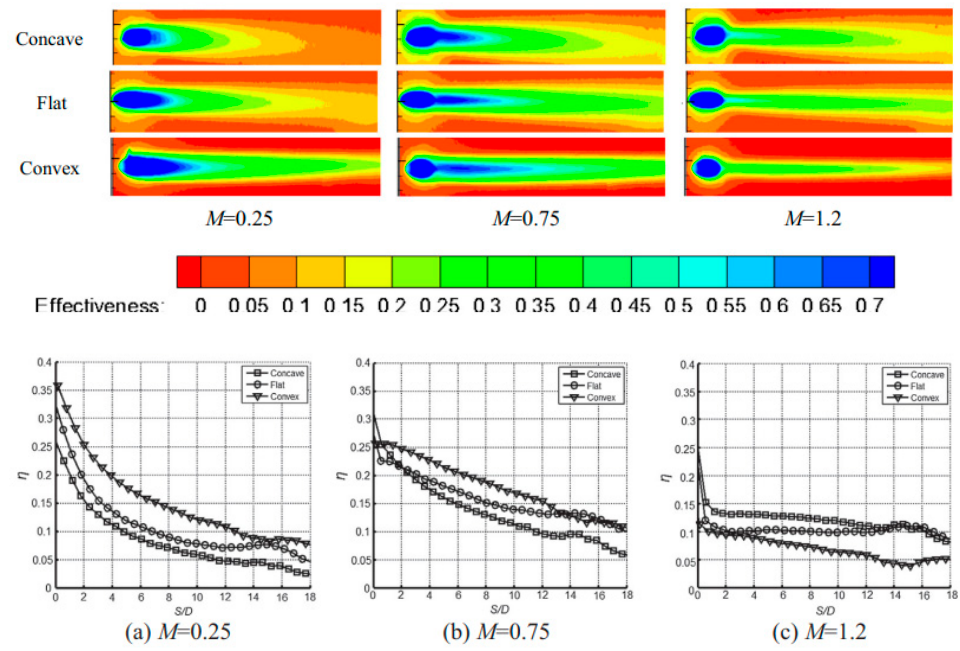
Figure 15. Effect of curvature on film effectiveness [98]. More on curvature effect concave surface (pressure side) and convex surface (Suction side) in Schwarz et al. [41].